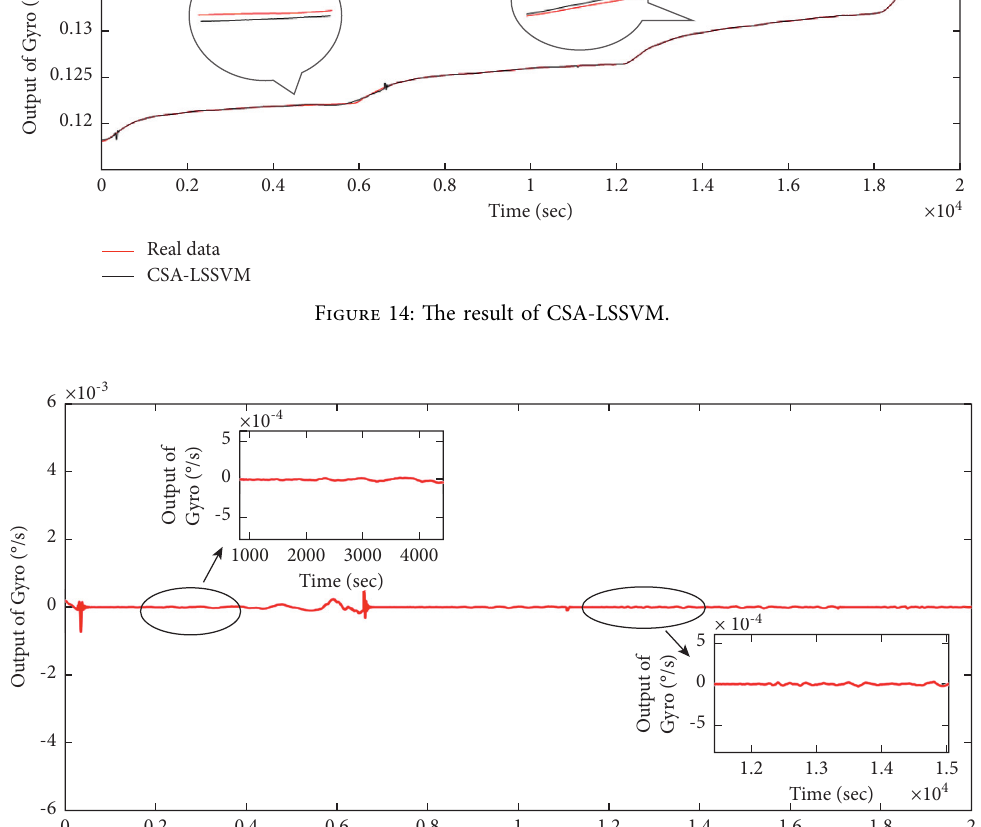
Figure 15: The reconstructed signal of temperature drift